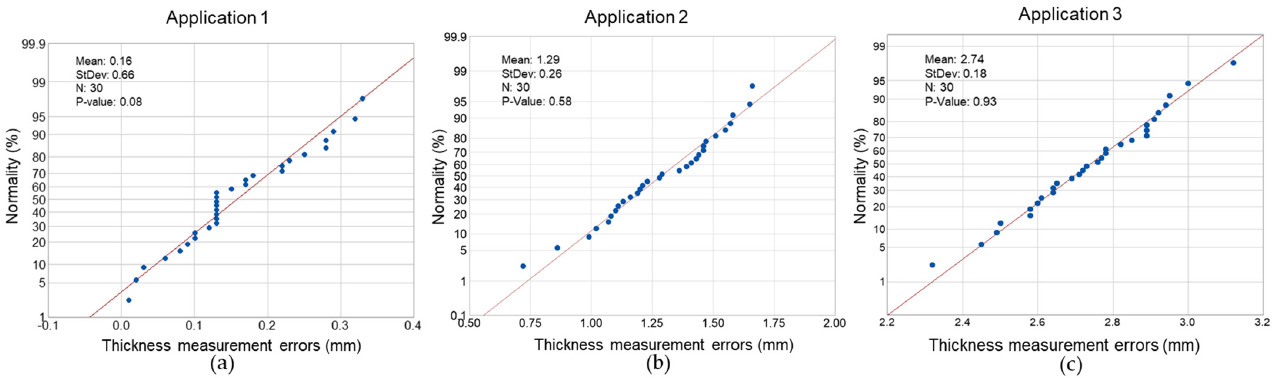
Figure 6. Testing the normality of the thickness measurement error data of Applications ( a ) 1, ( b ) 2, and ( c ) 3.